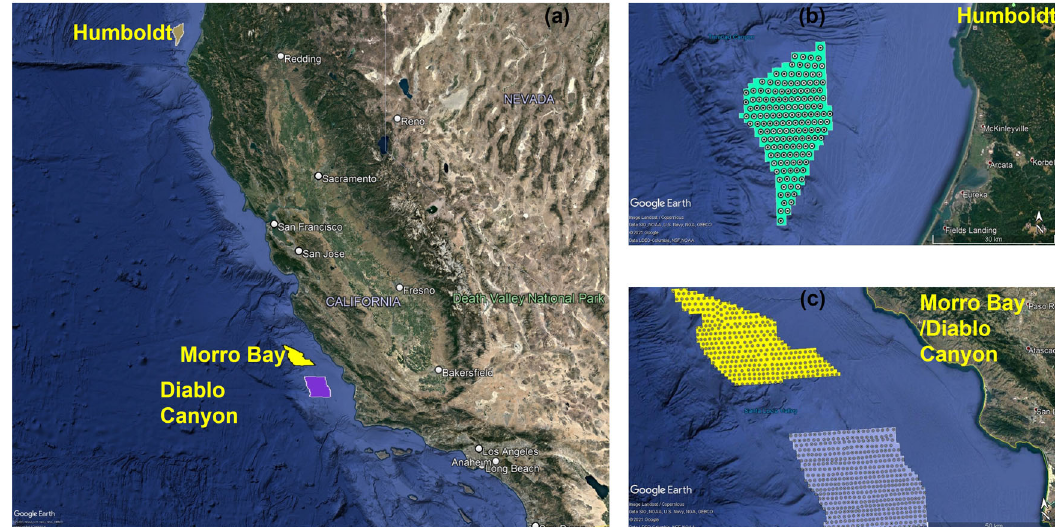
Fig. 2 Location of wind energy areas of interest along the California coast, and modeled layouts of turbines. a Wind areas of interest at Humboldt, Morro Bay, and Diablo Canyon, b modeled turbine layout at the Humboldt area of interest, and, c modeled turbine layout at the Morro Bay/Diablo Canyon wind energy area of interest. The circles within each area of interest represent the locations of modeled wind turbines. Note that since the start of this study, the Morro Bay wind energy area was reduced from 399 to 376 square miles. Also, as of December 2022, Morro Bay and Humboldt are recognized as California wind energy lease areas; Diablo Canyon area is not currently being considered for offshore wind planning. Maps Data: Google ⓒ 2021, Image Landsat/Copernicus, SIO, NOAA, U.S. Navy, NGA, GEBCO, LDEO-Columbia,